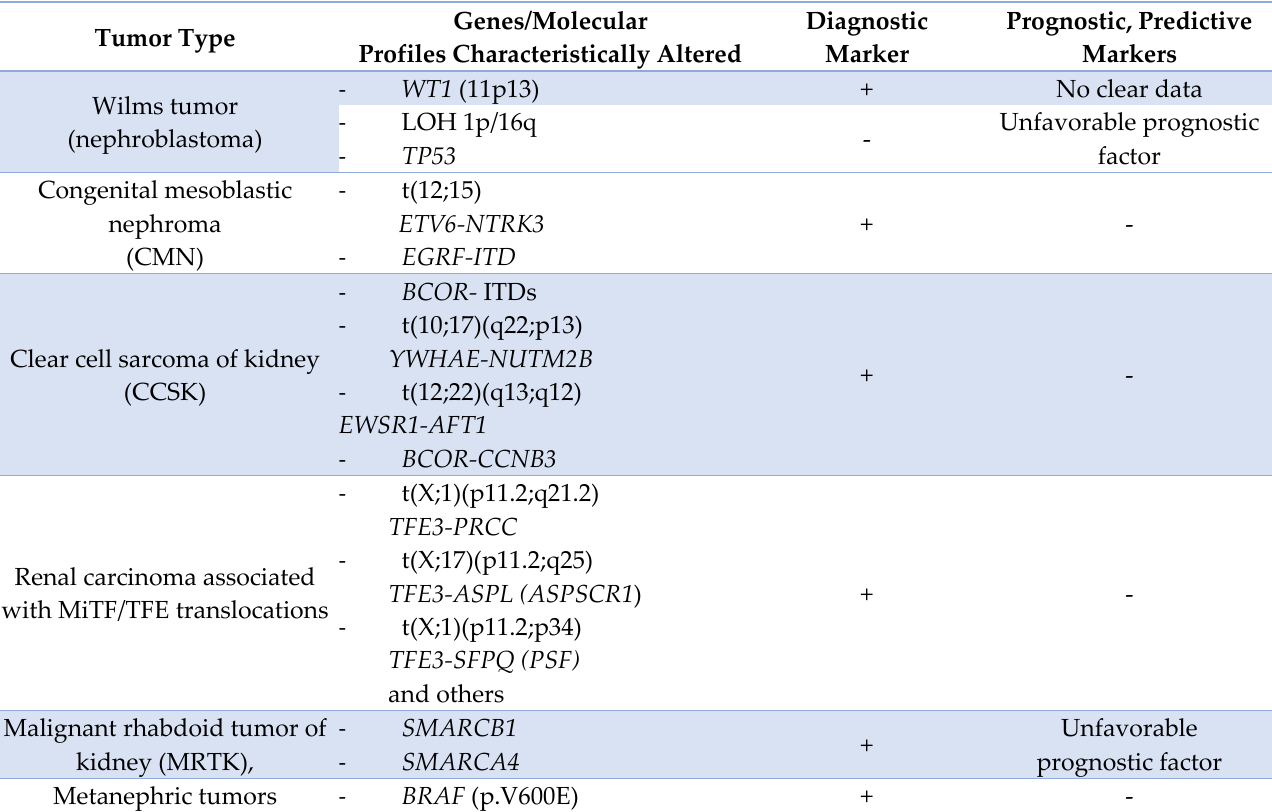
Table 3. Molecular markers—renal tumors of childhood.